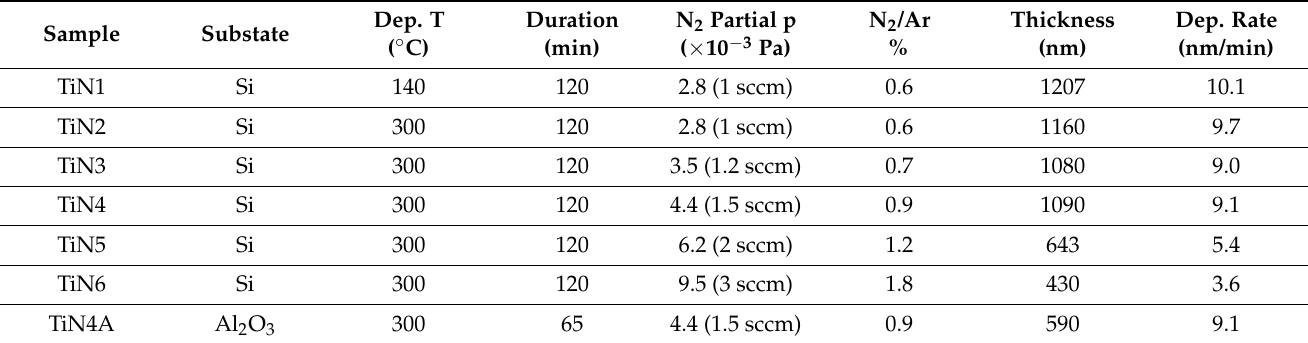
Table 1. Thickness and deposition rate of grown titanium nitride samples while varying the quantity of nitrogen during the sputtering